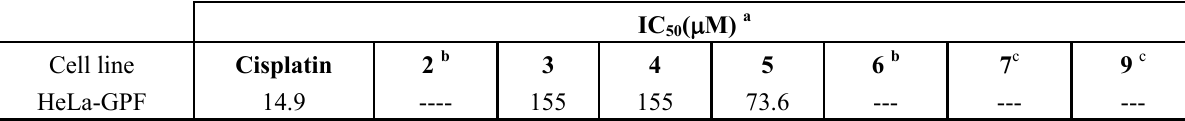
Figure 2. In vitro cytotoxicity of compounds 3 - 5 , 7 and 9 against normal cells (conc. μ M). Cytotoxicity was monitored by using live-cell imaging of a normal primary culture of adherent cells obtained from C57B6 mouse muscle explants after 22 hrs of incubation with the compounds. Each bar represents average value of three measurements and error bars represent standard deviations. Results for compound 3 at 200 µM are not shown since there was no cytotoxicity observed. Three controls were included; untreated cells (Unt), treated with 0.5% v/v diluent of the chemical compounds (DMSO) and treated with 1 mM H